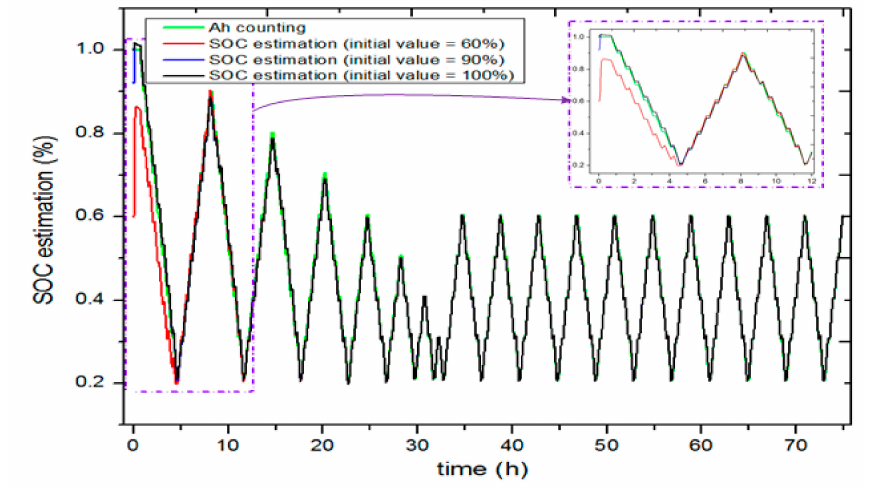
Figure 10. SOC estimation result with different initial